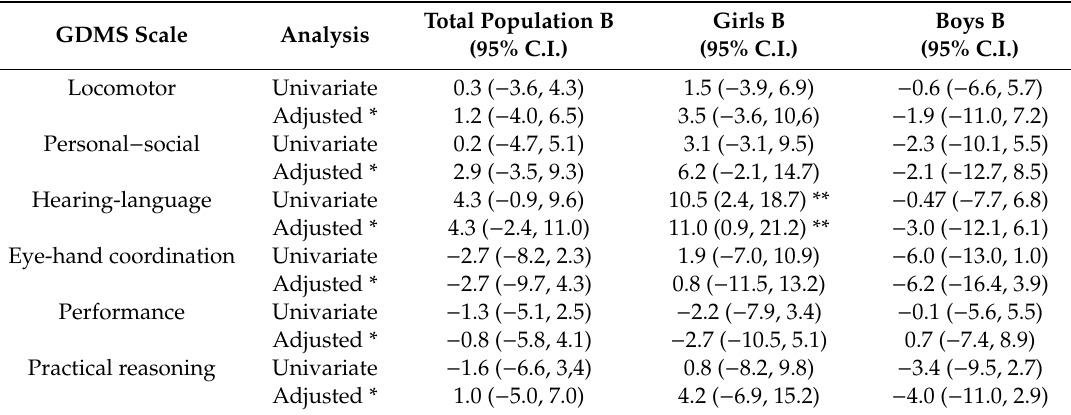
Table 2. Associations between exclusive breastfeeding and cognitive scores at five